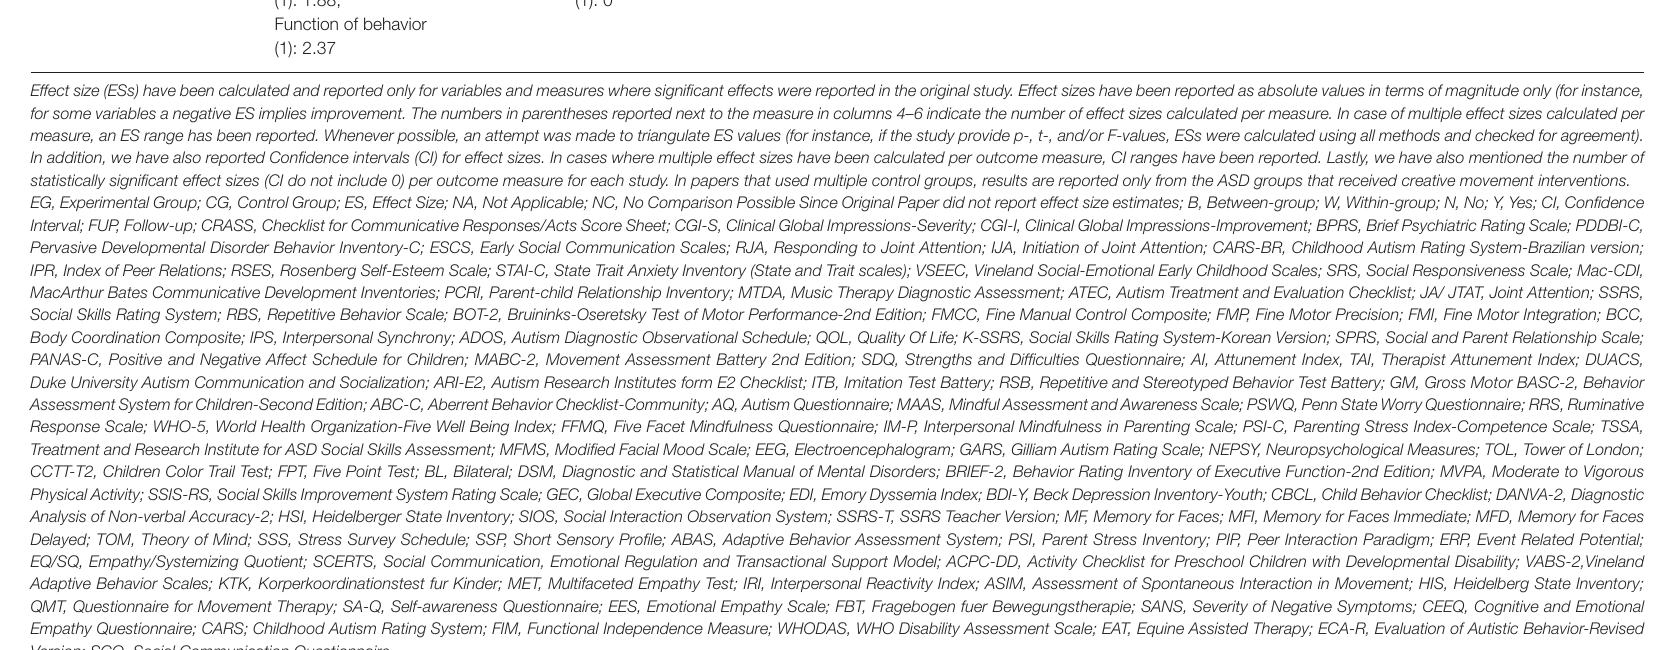
Poor Non-parametric statistics i.e., Wilcoxon’s signed rank test used and Z -scores reported. Thus, the Kerby’s formula of r = Z/(sqrt)N was used ( N = number of observations made and r = ES estimate)